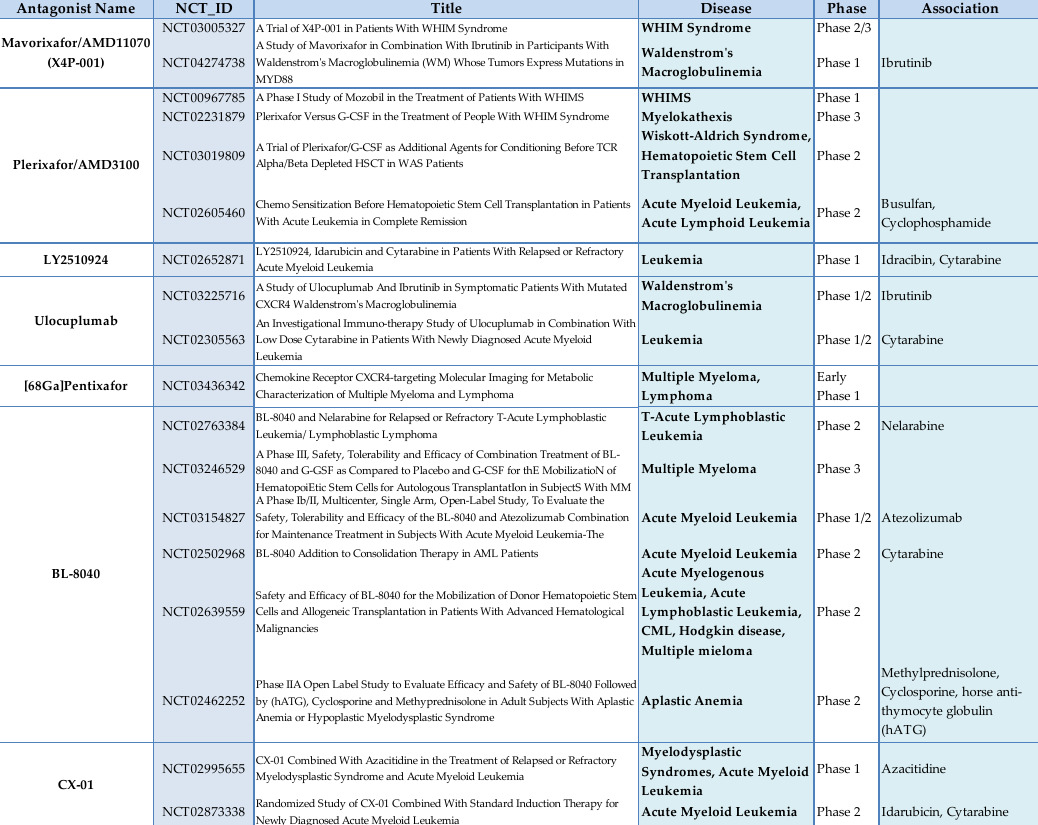
Figure 4. CXCR4 antagonists in hematological